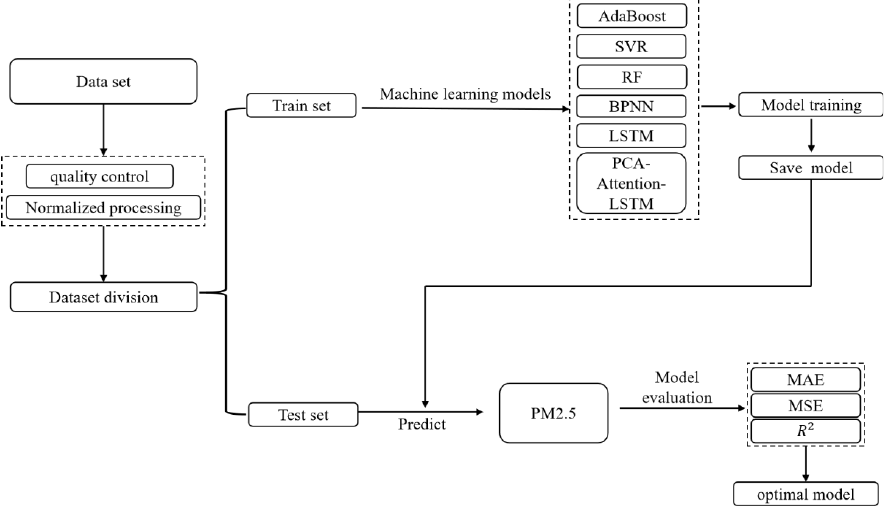
Figure 5. Experimental flow chart.